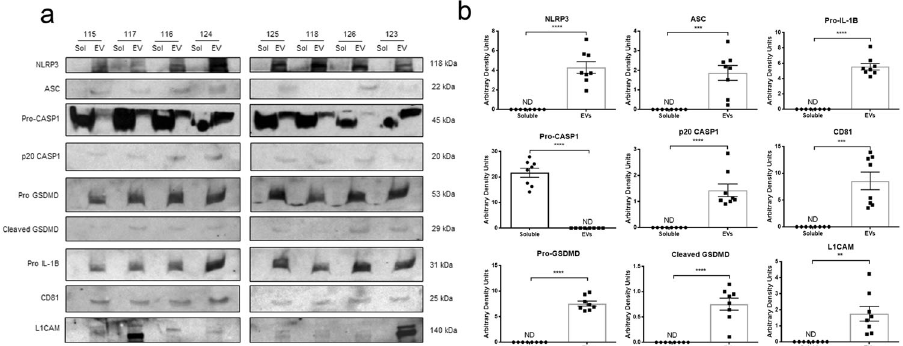
Fig. 3 In fl ammasome-related proteins are present in extracellular vesicles isolated from human plasma samples. a Extracellular vesicles (EVs) were isolated from fresh plasma samples using the ExoQuick Plasma Prep with Thrombin (EXOQ5TM-1, System Biosciences, Palo Alto, CA). The EV fractions were lysed and sonicated before analysis. The soluble and EV fractions from 8 plasma samples were analyzed via SDS – PAGE and subsequent immunoblotting. Anti-NLRP3, anti-ASC, anti-CASP1, anti-GSDMD, and anti-IL-1B antibodies were used for the detection of in fl ammasome-related proteins. Anti-CD81 and anti-L1CAM antibodies were used to con fi rm the purity of the EV fraction and assess the presence of neural-derived EVs, respectively. b The presence of in fl ammasome-related proteins was most often found solely in the EV fraction and the detection of EV-speci fi c markers was found only in the EV fraction. All statistical analyses were performed using unpaired Students t -tests (NLRP3, **** P < 0.0001) (ASC, *** P = 0.0002) (Pro-CASP1, **** P < 0.0001) (p20 CASP1, **** P < 0.0001) (Pro-GSDMD, **** P